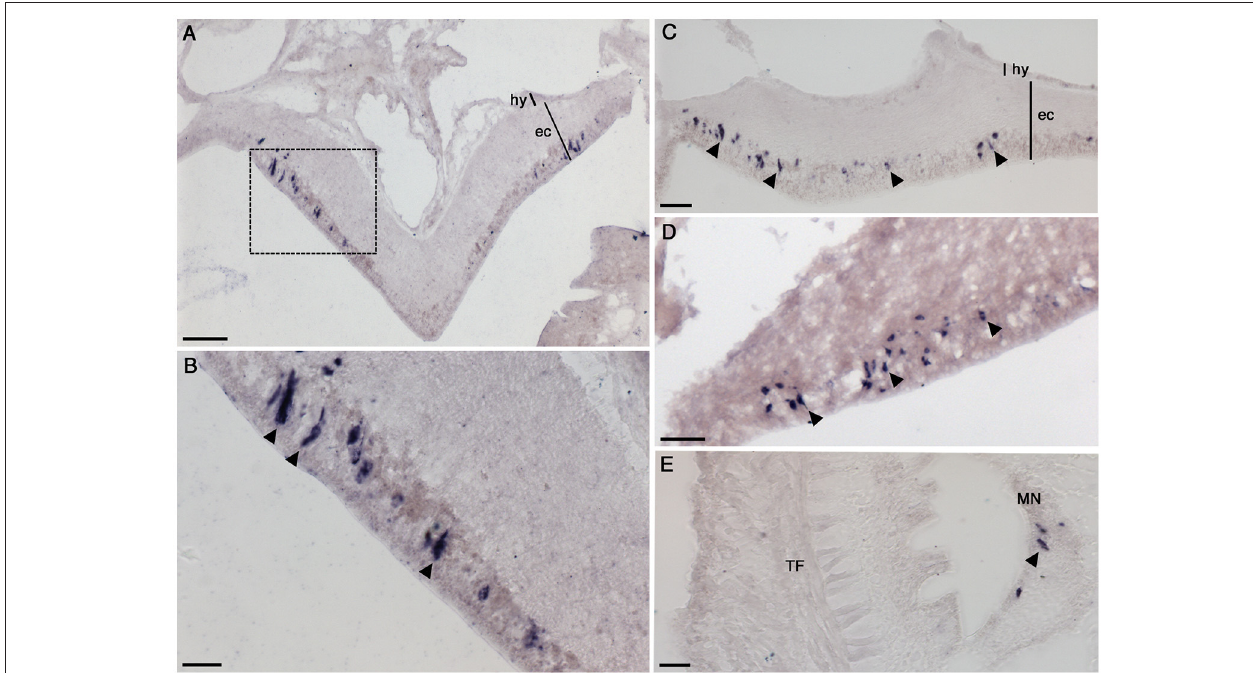
FIGURE 4 | Localization of NGFFYamide precursor mRNA expression in the nervous system of A. rubens . (A) Transverse section of a radial nerve cord showing stained cells in the epithelium of the ectoneural region, largely concentrated laterally. Note the absence of stained cells in the hyponeural region. The boxed region is shown at a higher magnification in (B) , where the elongate, bipolar shape of stained cells (arrowheads) can be seen. (C) Longitudinal section of a radial nerve cord showing stained cells (arrowheads) along the length of the epithelium in the ectoneural region (arrowheads). (D) Stained cells (arrowheads) in the ectoneural epithelium of the circumoral nerve ring. (E) Transverse section of an arm showing stained cells (arrowhead) in the marginal nerve, which is located lateral to the outer row of tube feet on each side of the arm. ec, ectoneural; hy, hyponeural; MN, marginal nerve; TF, tube foot. Scale bars: (A) : 33 µ m; (B) : 16 µ m; (C) : 16 µ m; (D) : 33 µ m; (E) : 16 µ